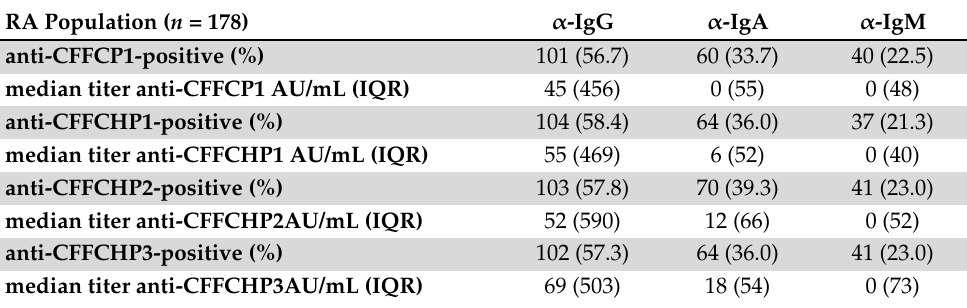
Table 1. Anti-ACPA and anti-AMPA fine specificities in RA